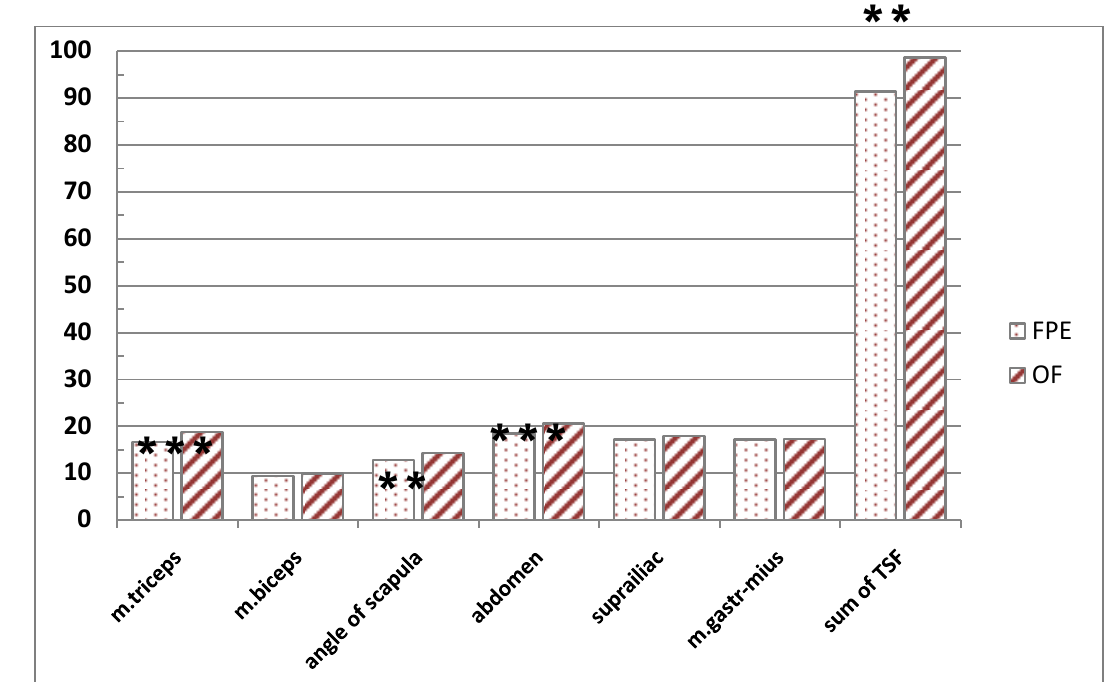
Figure 2. The mean values of the thickness of skin folds of female students at 3-4th courses studying on the faculty of physical education (FPE) and other faculties (OF)